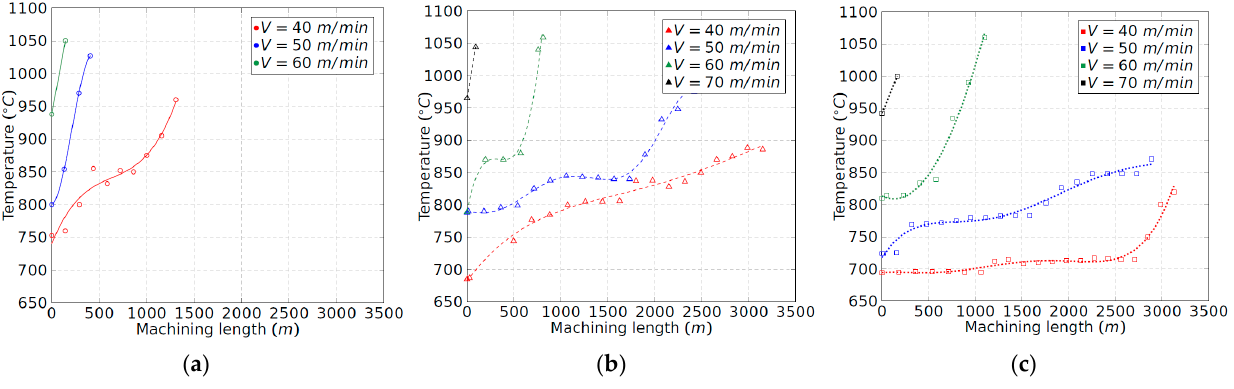
Figure 11. Tool–workpiece contact temperature due to the friction phenomenon in the flank wear zone: ( a ) tool configuration 1; ( b ) tool configuration 2; and ( c ) tool configuration 3.